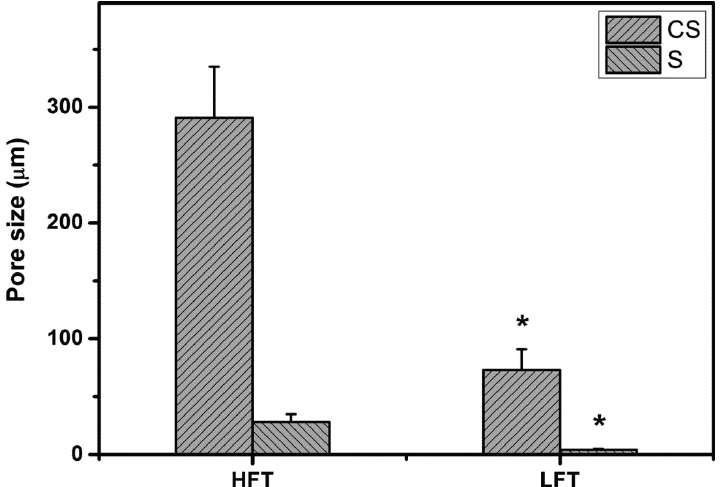
Figure 2. Pore size of various HA carriers. An asterisk indicates statistically-significant differences ( * p < 0.05; n = 4) vs. HFT (compared only within the CS or S